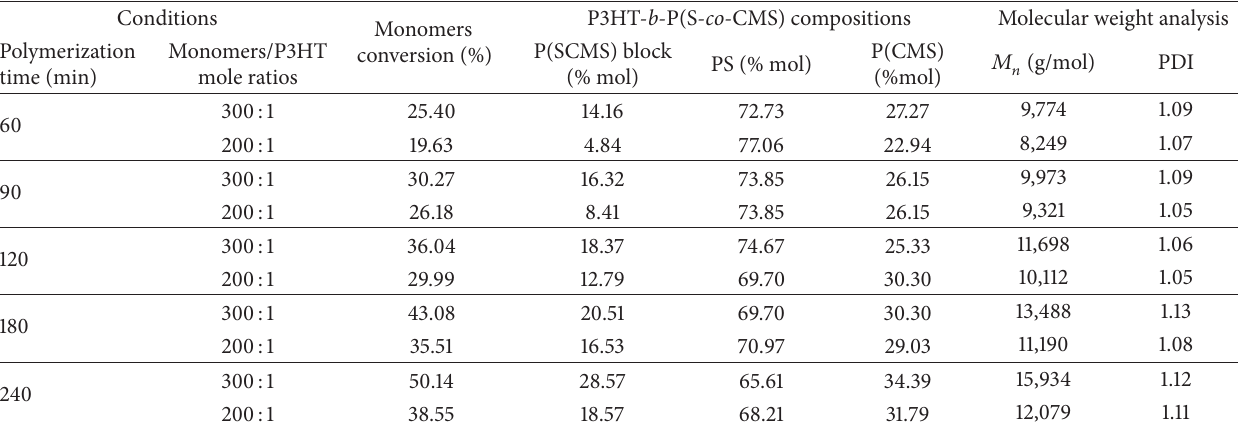
Table 2: Effects of monomer :macroinitiator mole ratios and polymerization times on monomers conversions, molecular weights, and compositions of the P3HT- b -P(S- co -CMS) copolymers obtained from ATRP of styrene and chloromethylstyrene.